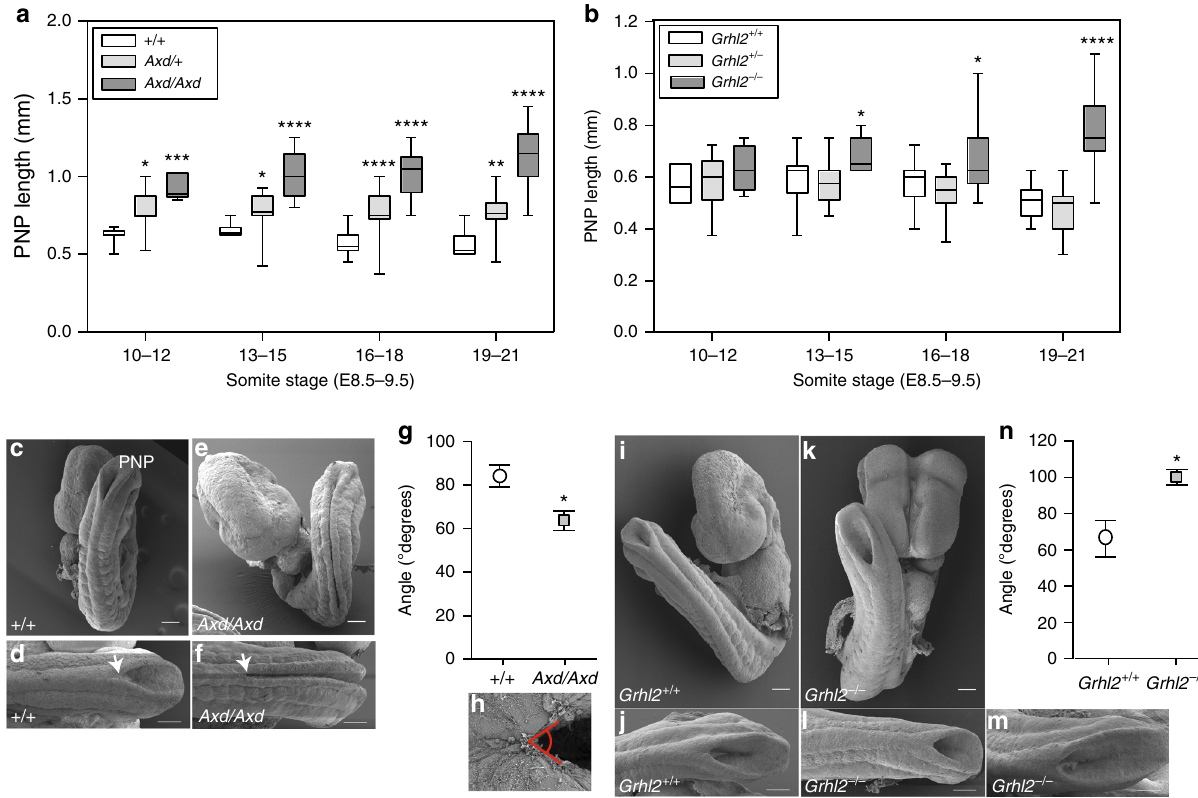
Fig. 1 Excess or lack of Grhl2 prevents PNP closure with differing PNP morphology at developmental stages from E8.5-9.5. a The PNP length of Axd/Axd and Axd/ + embryos was signi fi cantly enlarged compared with + / + embryos ( n = 215 embryos; 6 – 43 per genotype per stage; Supplementary Table 1). b The PNP length of Grhl2 − / − embryos was enlarged from the 13 – 15 somite stage (E9.0) onwards, whereas Grhl2 + / − embryos did not differ from wild types ( n = 307 embryos; 4 – 55 per genotype per stage; Supplementary Table 1). **** p < 0.0001, *** p < 0.001, ** p < 0.01, * p < 0.05 (ANOVA). c – f SEM of E9.5 embryos (18 – 19 somites) shows that PNP of Axd/Axd embryos is enlongated and very narrow compared with the PNP of wild-type embryos ( d , f ; arrows indicate rostral limit (closure point) of PNP). i – m The enlarged PNP of Grhl2 − / − embryos is characterised by widely spaced neural folds at E9.5 (examples have 20 – 21 somites). Consequently, the angle between the open neural folds (shown in h ) is signi fi cantly smaller in Axd/Axd ( g ) and greater in Grhl2 − / − ( n ) embryos than in + / + (* p < 0.05; n = 4 – 8 per genotype; Data represents mean ± SEM). Wild-type embryos did not differ between strains ( g , n ). Scale bars: 100 μ m. Source data are provided as a Source Data fi